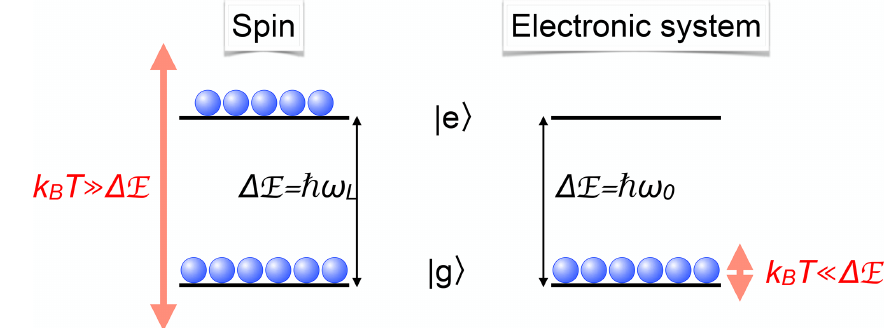
Figure 1. Comparison of spin and optical transitions with the corresponding populations at room temperature.